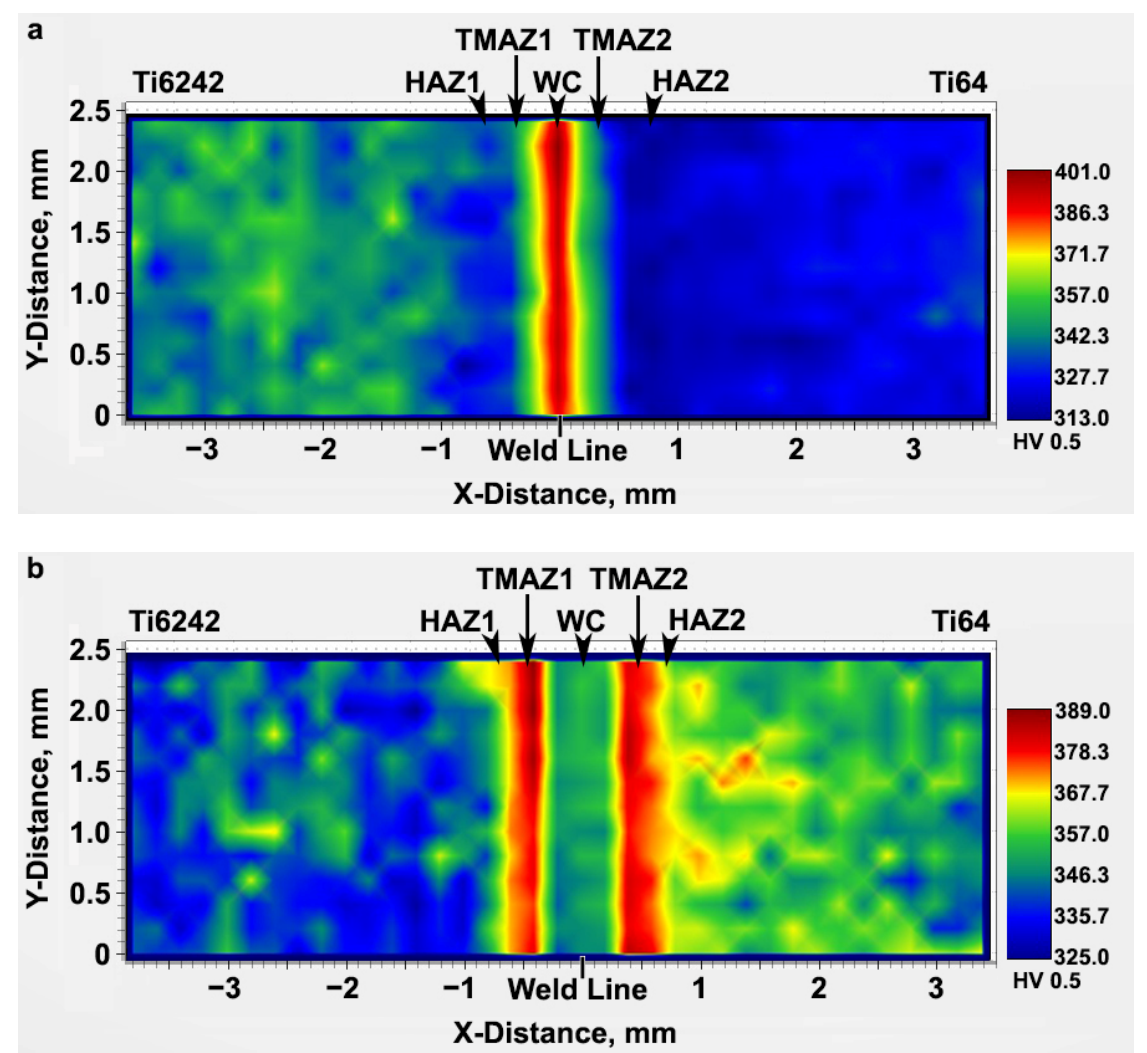
Figure 3. Microhardness maps across the dissimilar Ti6242–Ti64 linear friction welds showing the weld line, weld center (WC), heat-affected zones (HAZs), thermomechanically affected zone (TMAZs), as well as the Ti6242 and Ti64 BMs: ( a ) as-welded (AWed) and ( b ) stress relief annealed (SRAed).